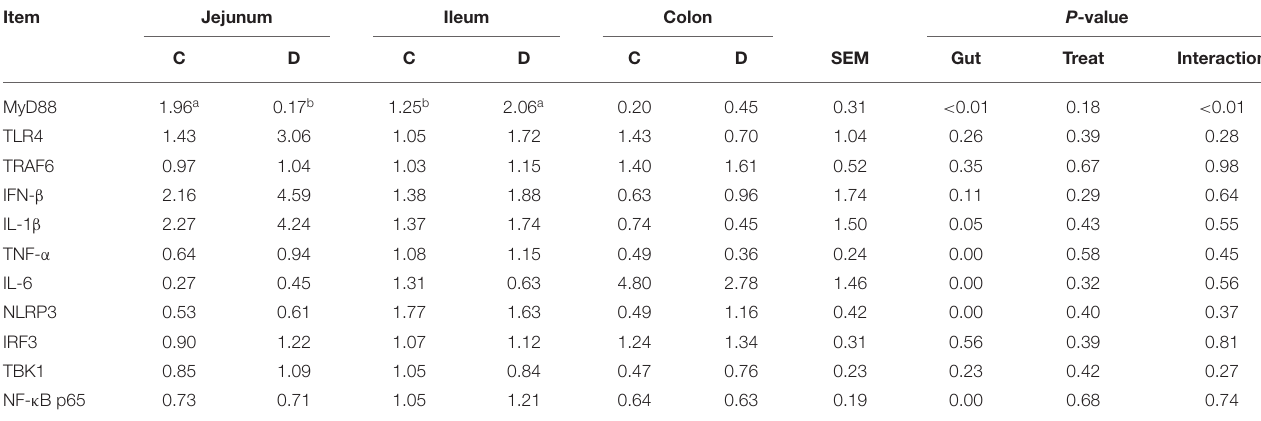
TABLE 2 | The expression of genes related to TLR4 pathway in the lower gut. Item Jejunum Ileum Colon P -value